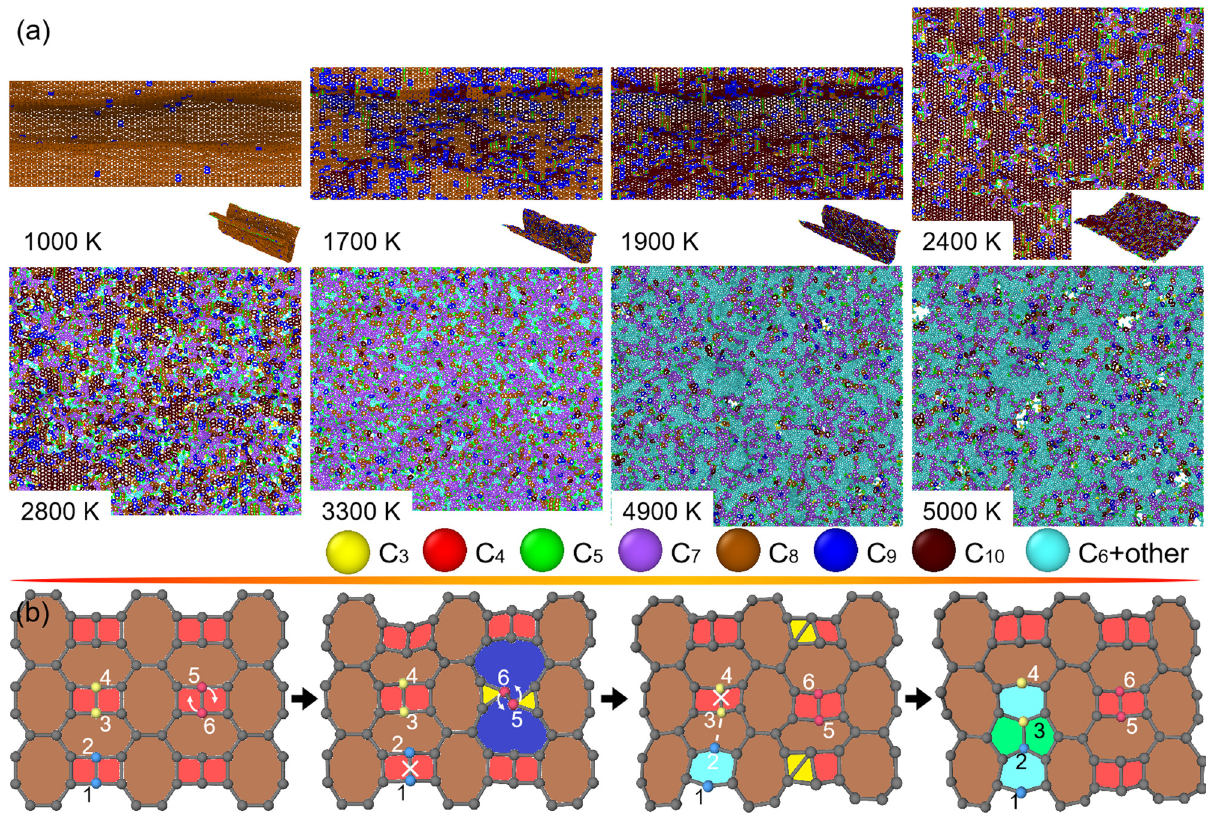
Figure 9: Structural changes in S - graphene subjected to heating. ( a ) Top views of O - haeckelite as the heating T increases from around 1,000 to 5,400Kintomeltingphase.Foreye - catchingthethermallyinducedstructuraltransformationintheO - haeckelite,carbonatomsinpolygonalringsfrom trigontodecagonaredi ff erentlyrendered. ( b ) Atomicillustrationofnucleationofhexagonsfrompentagons,hexagons,andheptagonsinalocalregion of O - haeckelite. Particularly, some carbon atoms are number - ranked and arrows are marked for revealing the origins of microstructural